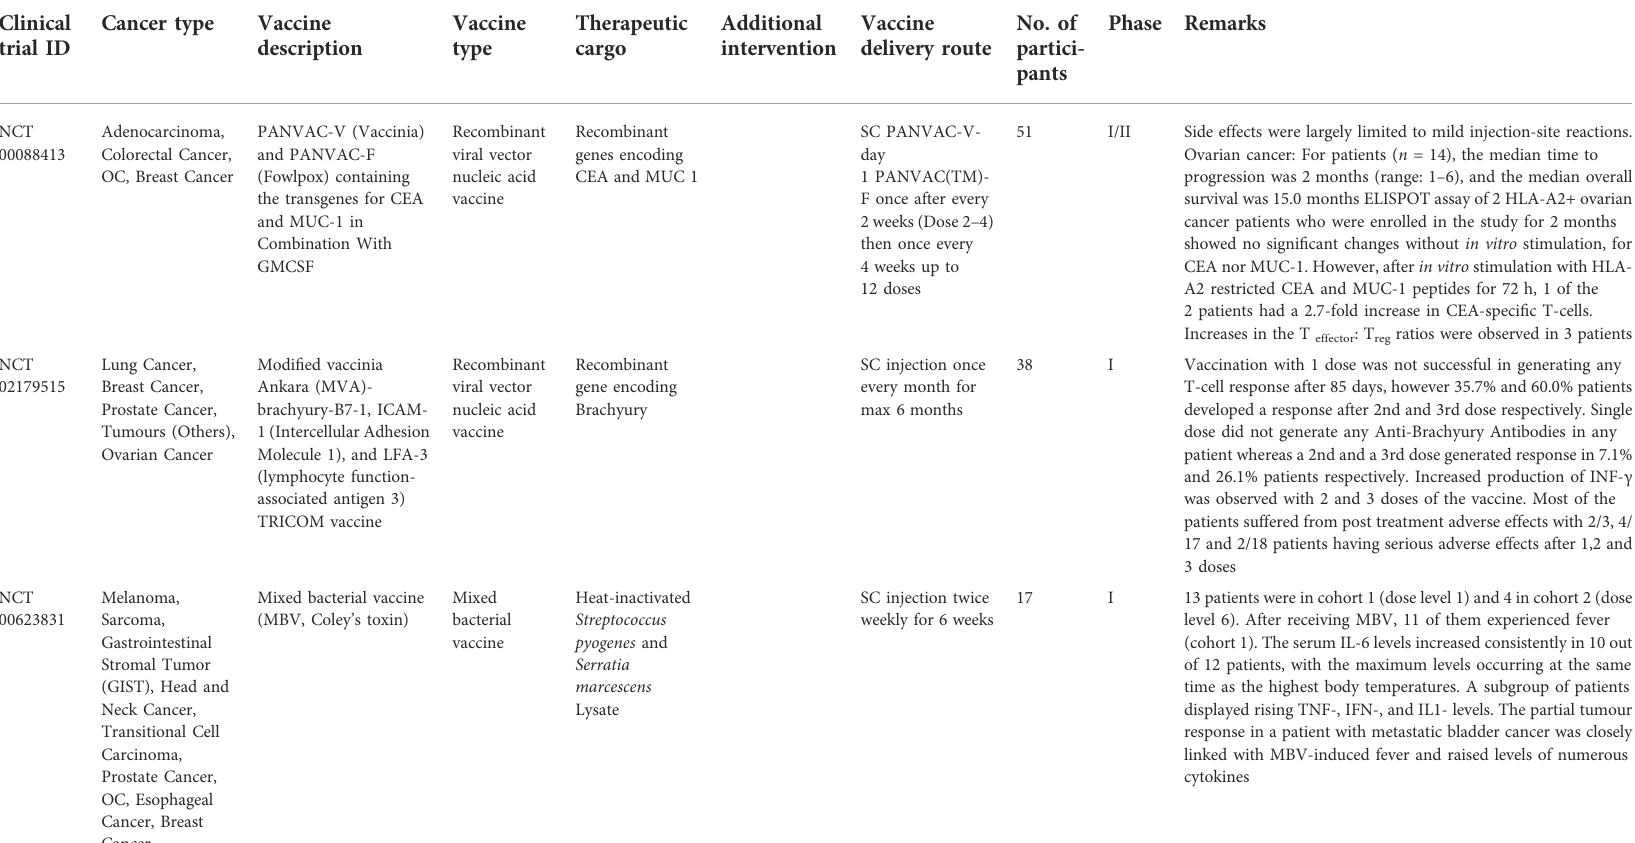
TABLE 2 ( Continued ) Table of completed clinical trials showing promising results for various cancer vaccines in OC. All of these vaccines have been used as a second line of treatment after initial cytoreductive debulking of the primary tumours and